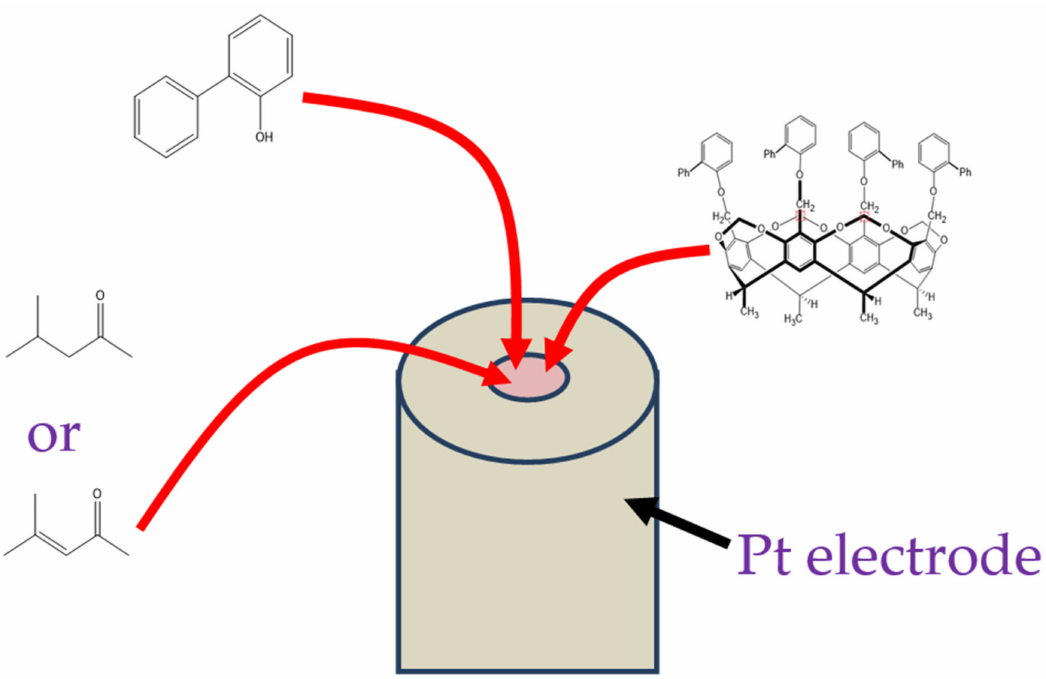
Figure 2. Schematic of the experimental design for the electropolymerization reactions of 2-phenylphenol.